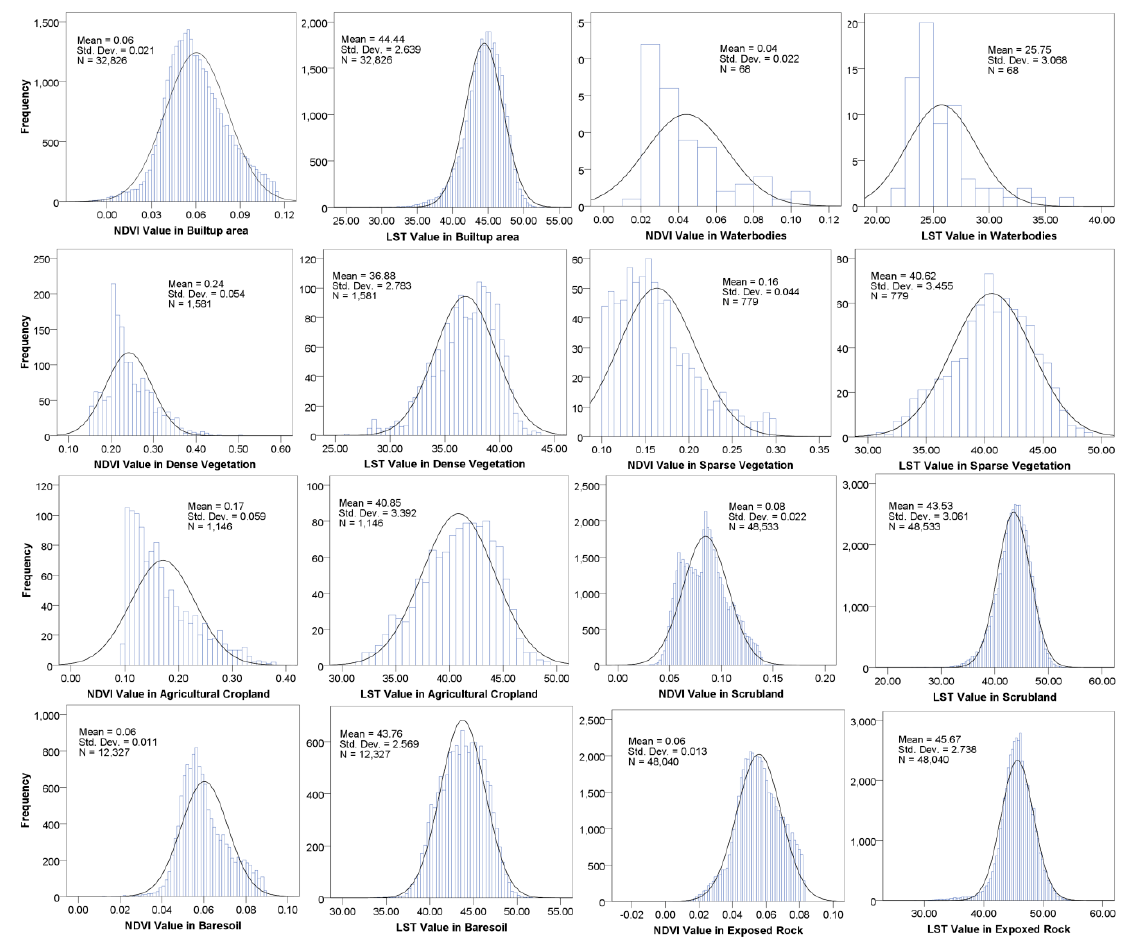
Figure 5. Histogram profile of NDVI and LST over different LULC.